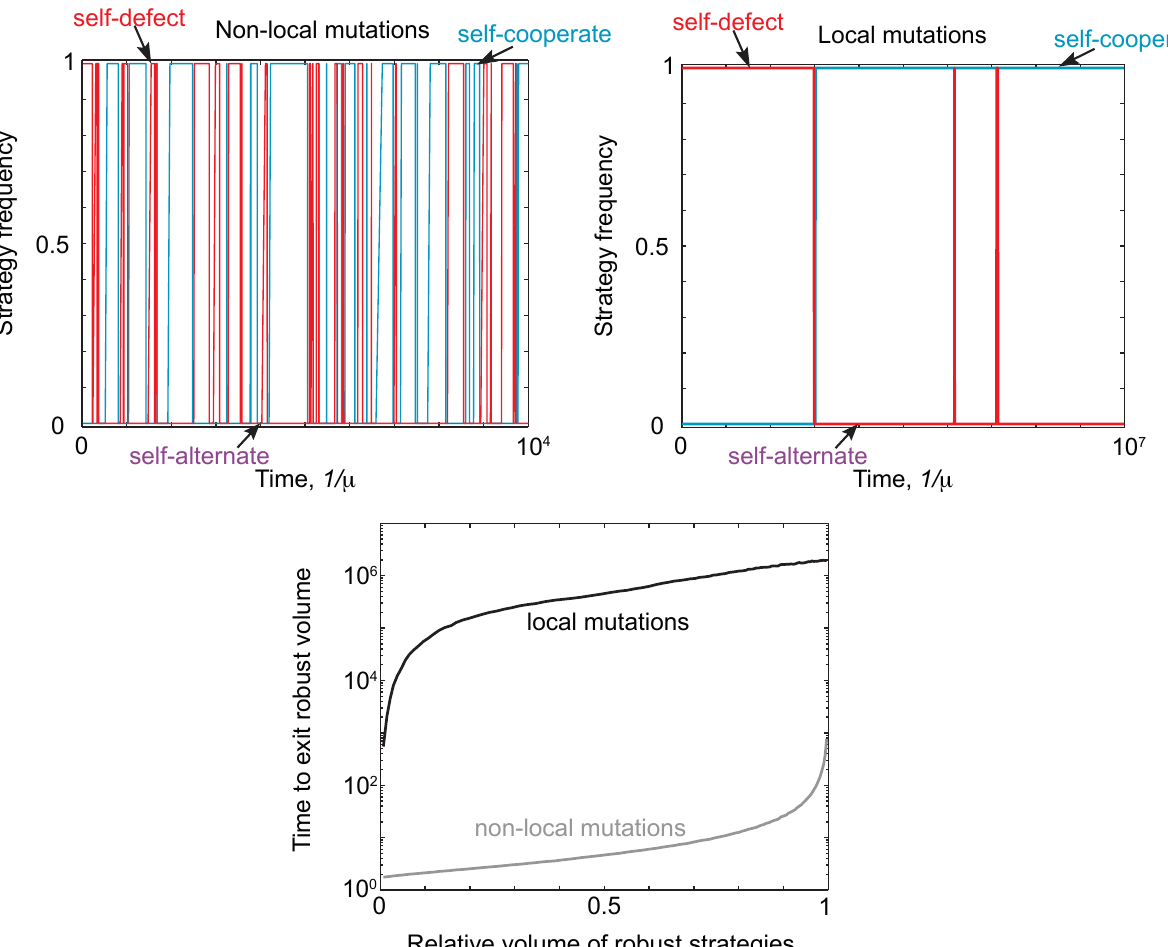
Figure 4. Neutral drift under local and non-local mutations. (Top) We simulated evolution under weak mutation, as described in Figure 3, initializing populations with the strategy always as defect, p = { 0 , 0 , 0 , 0 } , and payoffs b = 1 . 5 and c = 1 . We compared the trajectories for a single run under local and non-local mutations, comparing the frequency of self-cooperate, self-defect and self-alternate strategies. The population was assigned to a particular strategy class if it was within distance δ = 0 . 01 of that class. For non-local mutations, there is a rapid turnover of different strategy types, despite the population spending most of its time at self-cooperate or defect. For local mutations, the rate of turnover is many orders of magnitude slower, with 10 7 mutations only producing one turnover event between self-defect and self-cooperate. (Bottom) We calculated the time, averaged over 10 6 starting conditions, for a population to drift out of a region of robust strategies as a function of the volume. As expected, it takes far longer for the population to drift away from a region of robust strategies under local mutations, resulting in the slower turnover of strategy types seen in the top right